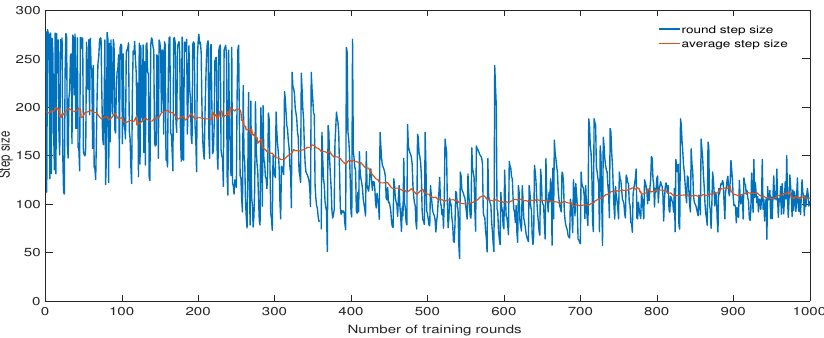
Figure 13. Turn step size and average step size variation